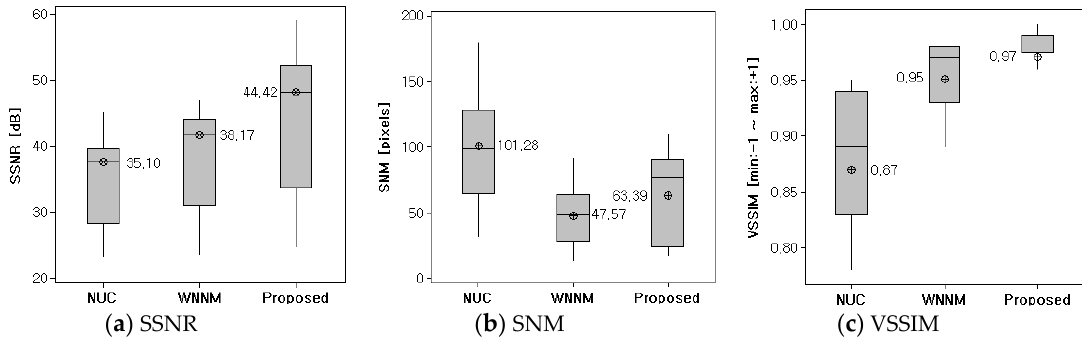
Figure 13. Boxplots and mean values of experimental results. ( a ) SSNR result; ( b ) SNM result; ( c ) VSSIM result.